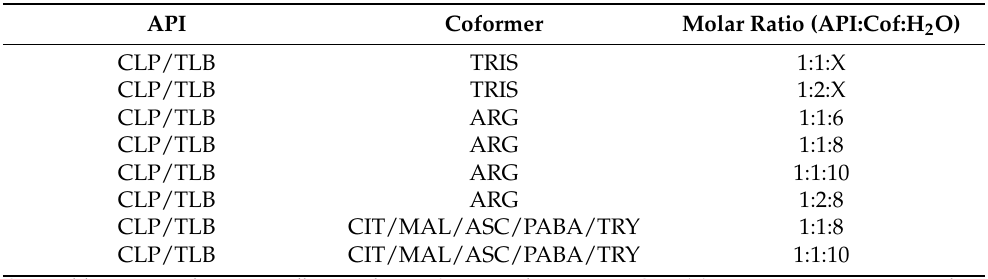
Table 1. Coformers and molar ratios between the APIs, and coformers and water tested to produce the THELES. X = 2, 4, 6, 8,